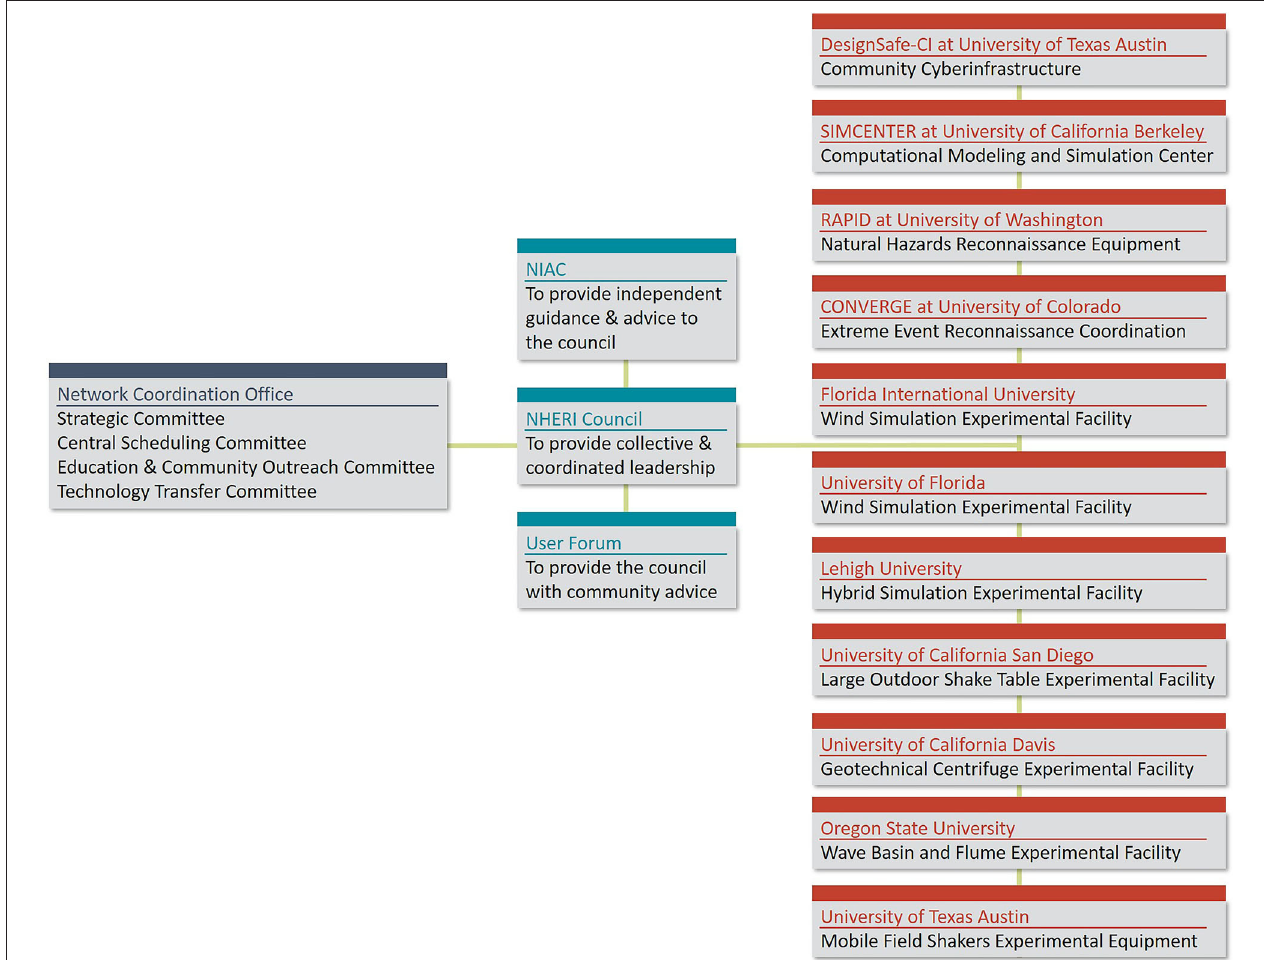
FIGURE 1 | Components of